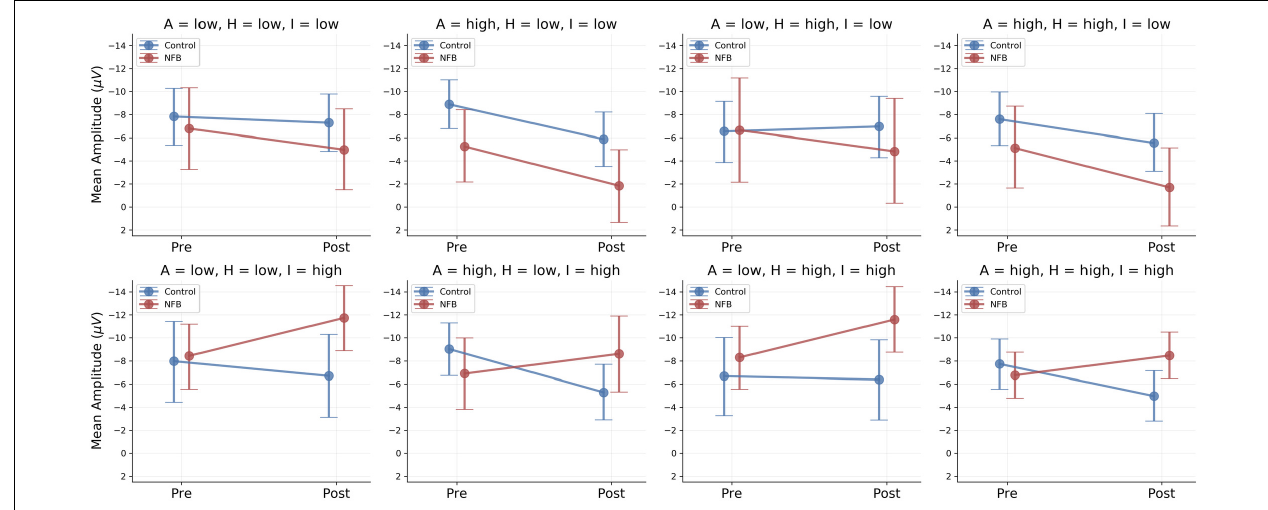
FIGURE 4 | Fine-grained moderator model results. Model-based predictions of population-level means across low and high scores of the moderator variables: A, Attention; H, Hyperactivity; I, Impulsivity. Points indicate predicted means: Red, Neurofeedback Group (NFB); Blue, Control Group. Error bars indicate 95% credibility intervals (predictive uncertainty). Only model-based predictions are depicted, since quasi-continuous moderators are conditioned on concrete values and no discrete subgroups were built for